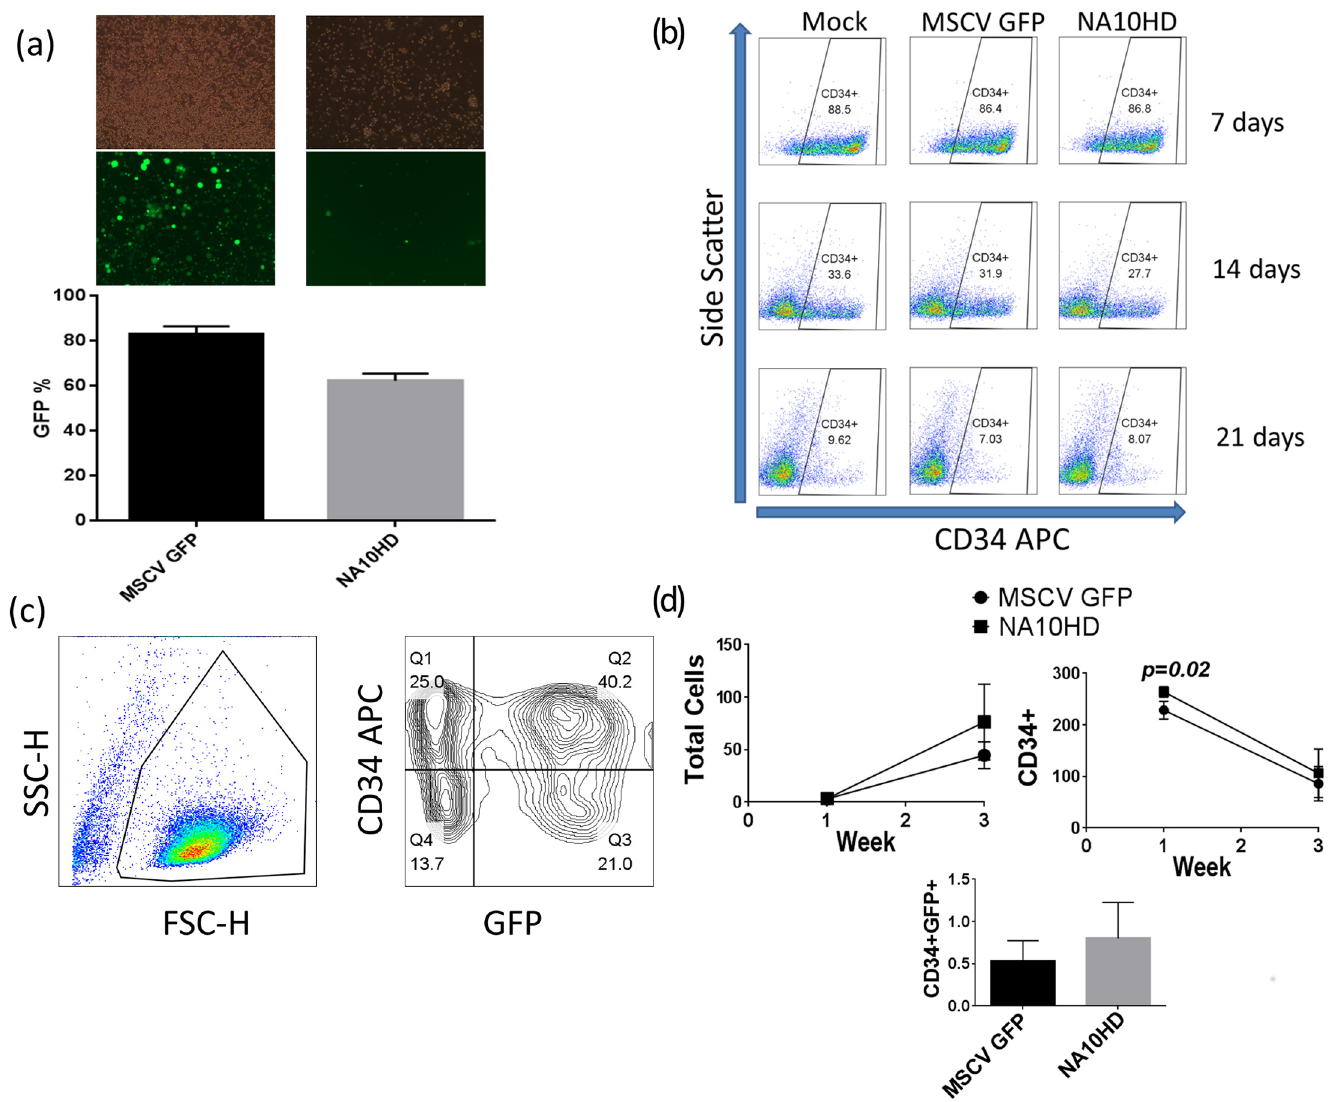
Fig 3. Transduction and culturing of human peripheral blood CD34+ cells. (a) GFP expression of CD34+ cells 1 week post lentiviral transduction as measured by brightfield (top row) and fluorescent (middle row) microscopy and flow cytometry (bottom row) 1 week post lentiviral vector exposure — vCL20c MSCV GFP as GFP control (MSCV GFP), vCCL-c-MNDU3 FLAG-NA10HD PGK GFP (NA10HD), (b) Similar appearance of CD34+ cells in culture at 1, 2 and 3 weeks post-transduction amongst the untransduced (Mock), MSCV GFP and NA10HD groups, (c) Gating strategy fog assessment of GFP positive CD34+ cells in long-term cell culture, (d) Cumulative fold increase analysis for total cells, CD34+ and CD34+GFP+ in culture for 3 weeks shows significantly higher CD34+ expansion at 1 week post lentiviral transduction in the NA10HD group (264 vs 228, p = 0.02, paired t-test, n = 5). Total cell, CD34+ and CD34 +GFP+ cell expansion in NA10HD vs. MSCVGFP at 3 weeks of cell culture was higher but did not meet statistical significance (p = 0.267, 0.344 and 0.323 respectively, paired t-test, n = 5).